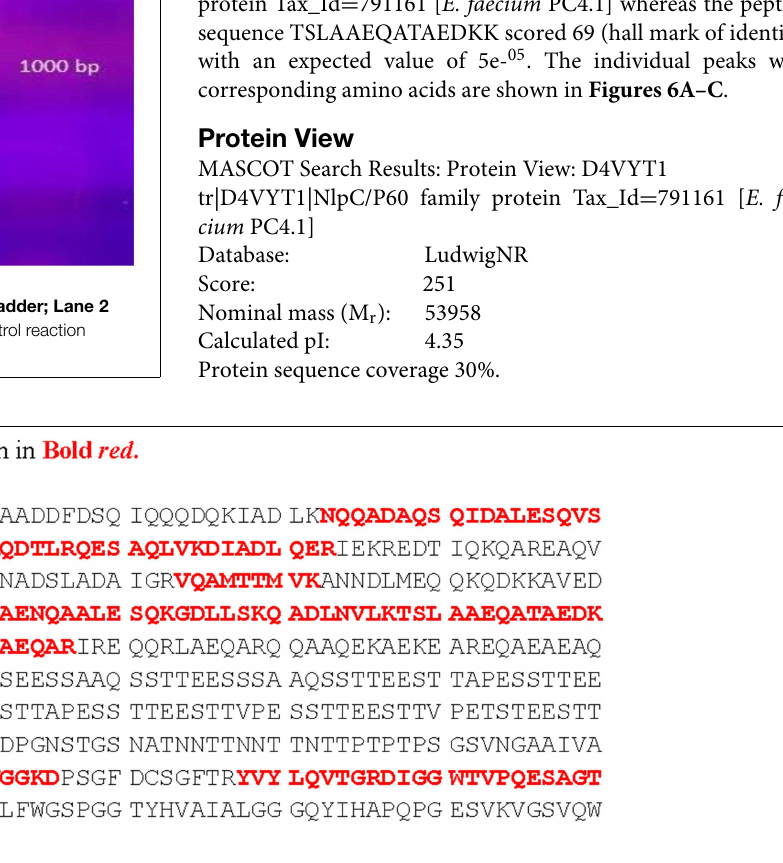
Frontiers in Microbiology |